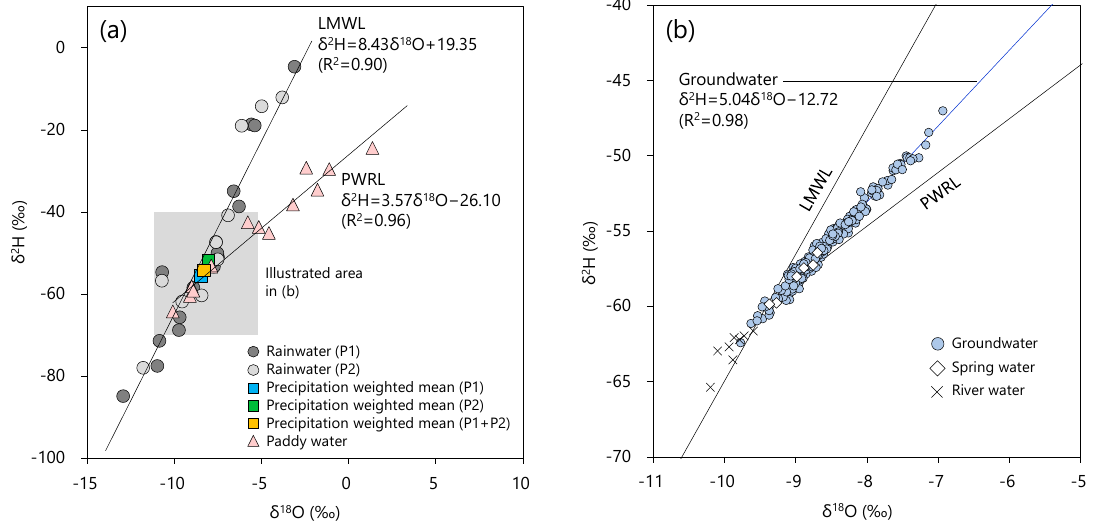
Figure 8. Relationship between δ 18 O and δ 2 H of ( a ) rainwater and paddy water and ( b ) groundwater. LMWL is the local meteoric water line identified by fitting a regression line to observations at sites P1 and P2. PWRL is the regression line fitted to the paddy water data.